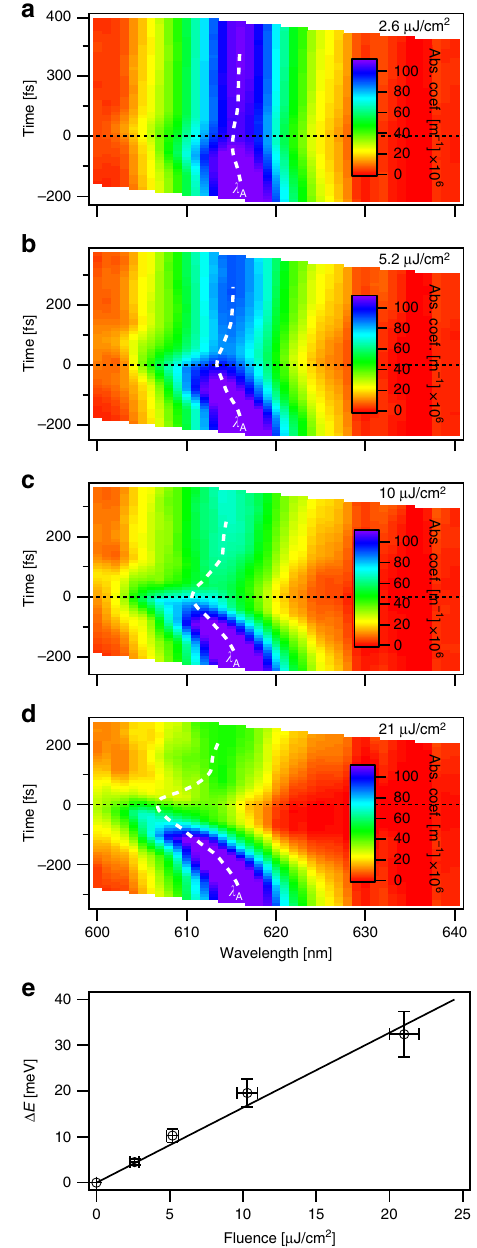
Fig. 5 Power dependence of the optical Stark effect. Time-dependent absorption spectra of monolayer WS 2 recorded for cocircularly polarized 610 nm pump pulses with incident fl uences of a 2.6, b 5.2, c 10, and d 21 µ J/cm 2 . The center wavelength of the A-exciton resonance ( λ A ) is indicated with a dashed white line. Time zero indicates when the pump and probe pulse are temporally overlapped. e Shows the fl uence dependence of the maximum optical Stark shift, Δ E . The error bars in fl uence represent the propagated uncertainty in pump power and beam diameter. The error bars in Δ E represent the sum of uncertainties in center wavelength of the unperturbed A-exciton absorption and of the absorption at time zero. The solid line is a fi t to Eq. (6) for 150 fs pulses, M gx = 5.2 ± 0.4 D, E b = 320 ± 40 meV, and a detuning of − 23